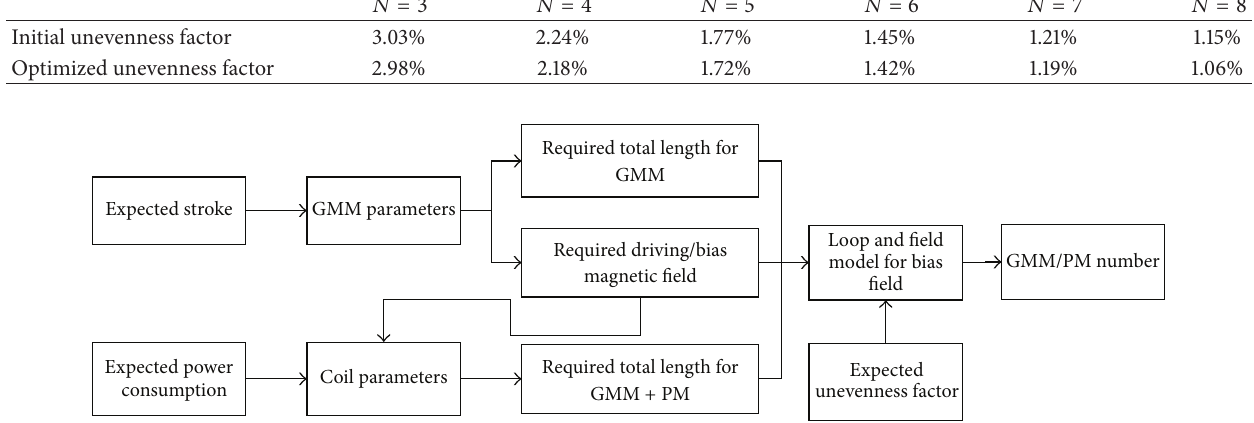
Figure 12: Design stages for the basic structure of SGMA.